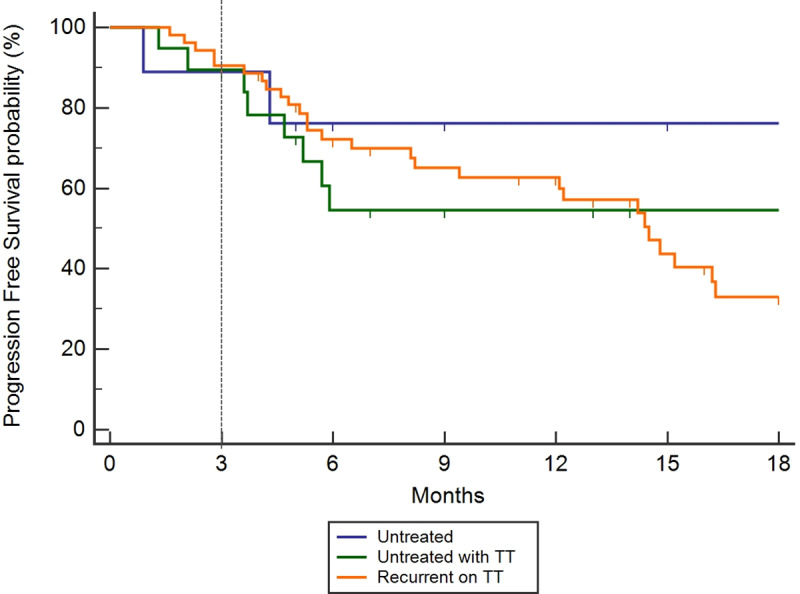
Kaplan Meier curve with stratification of groups, demonstrating the progression-free survival (PFS) for patients on an appropriate targeted therapeutic (TT) agent as determined by the identification of an actionable mutation.No significant difference was identified between patients who were untreated, TKI-naïve or recurrent to prior TKI therapy (p = 0.8552).